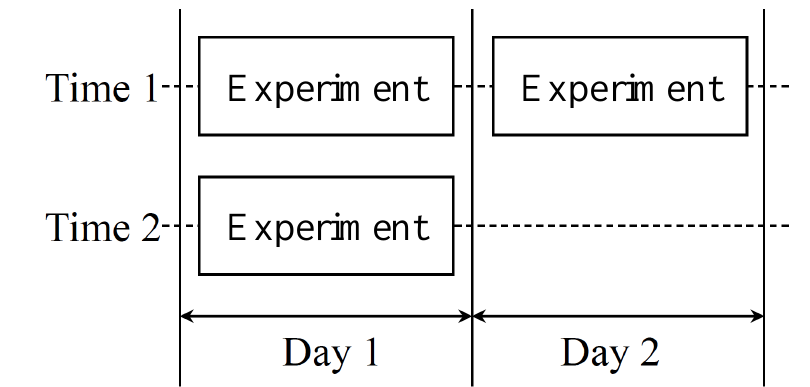
Figure 9. Schedule of the three data acquisition